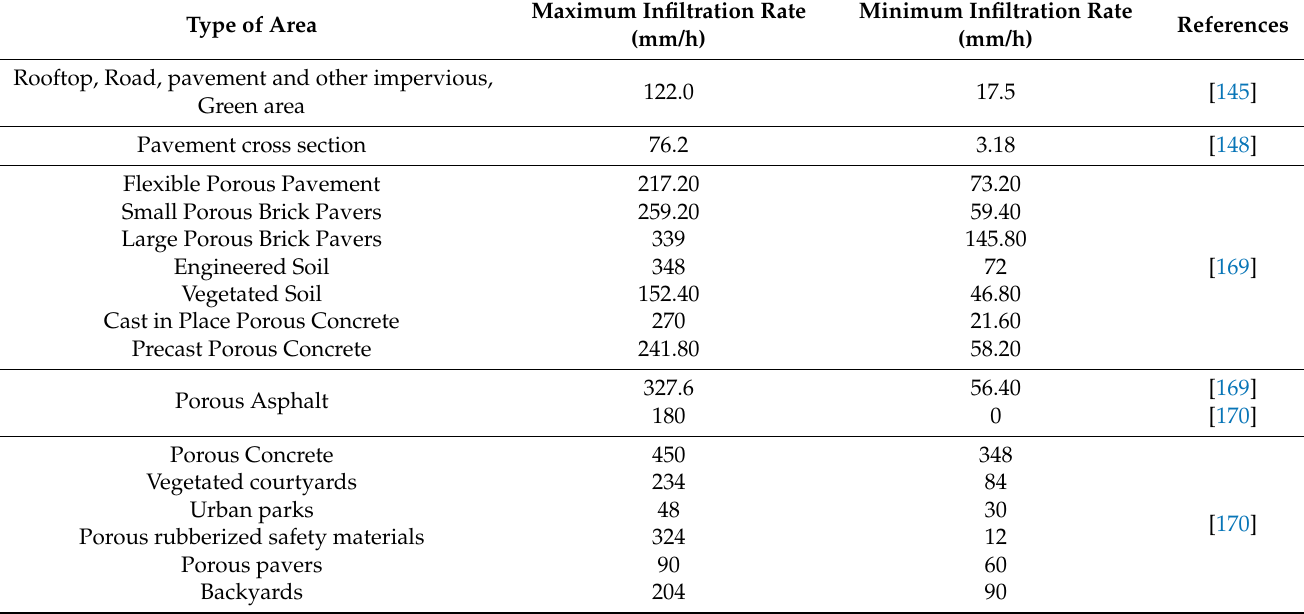
Table 5. Exemplary values of input data for Horton infiltration